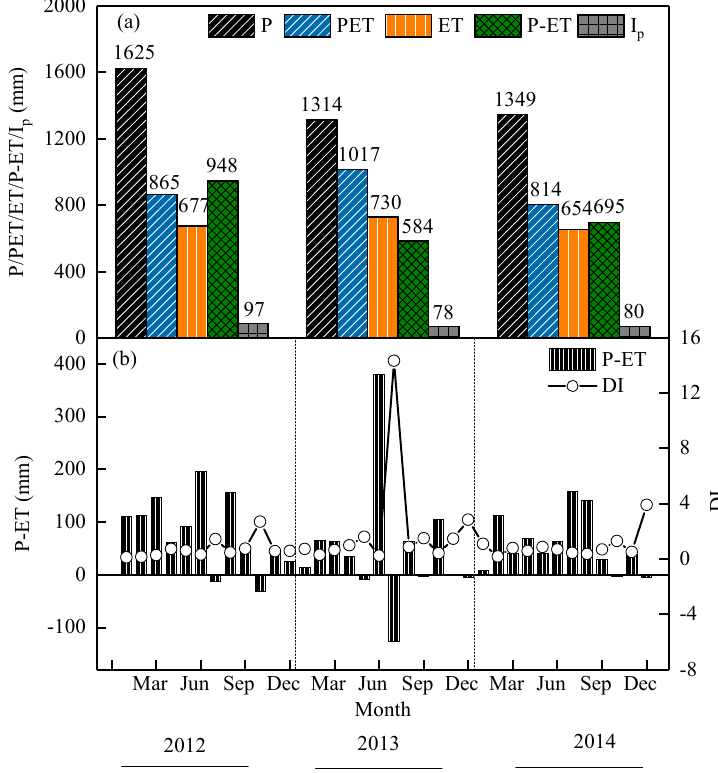
Figure 7. Water budgets between precipitation and evapotranspiration of Moso bamboo forest in drought periods. ( a ) Total precipitation ( P ), evapotranspiration (ET), potential ET (PET), canopy intercepted rainfall (I p ), and precipitation-deducted ET P-ET; ( b ) monthly P-ET and dryness index (DI) through time.